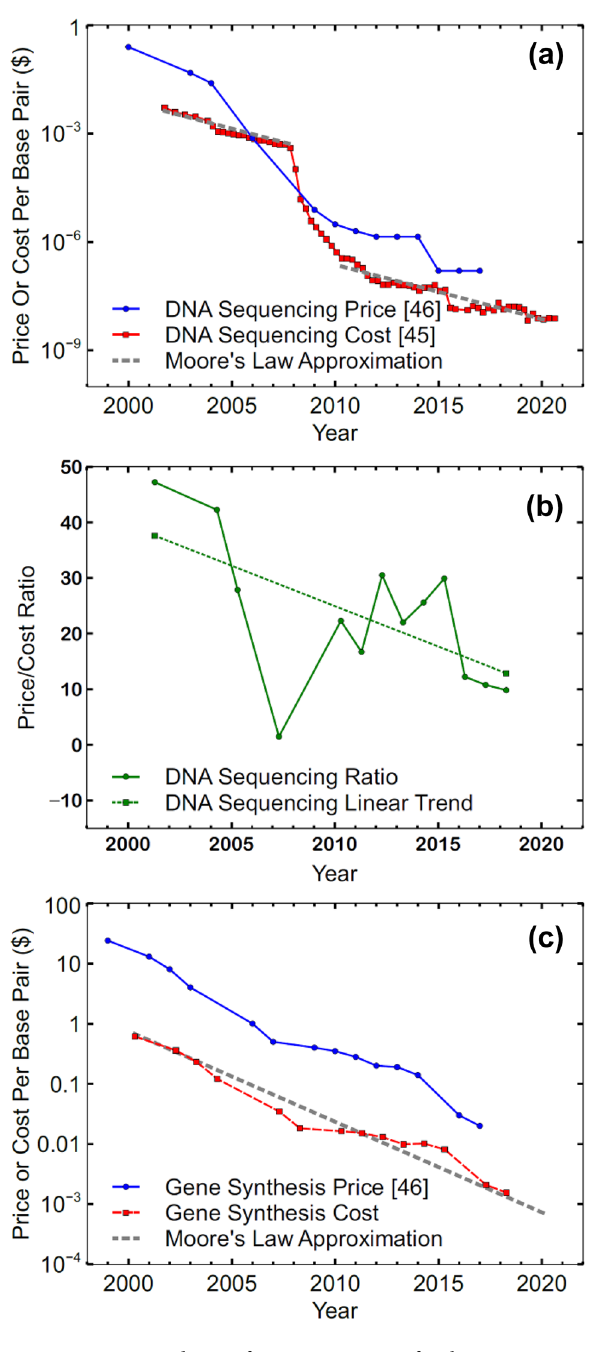
Figure 5. Price and cost of DNA sequencing for the 2000–2020 time period ( a ); price/cost ratio for DNA sequencing ( b ); price and cost of DNA synthesis ( c ) and comparison to an approximation of Moore’s Law 45,46